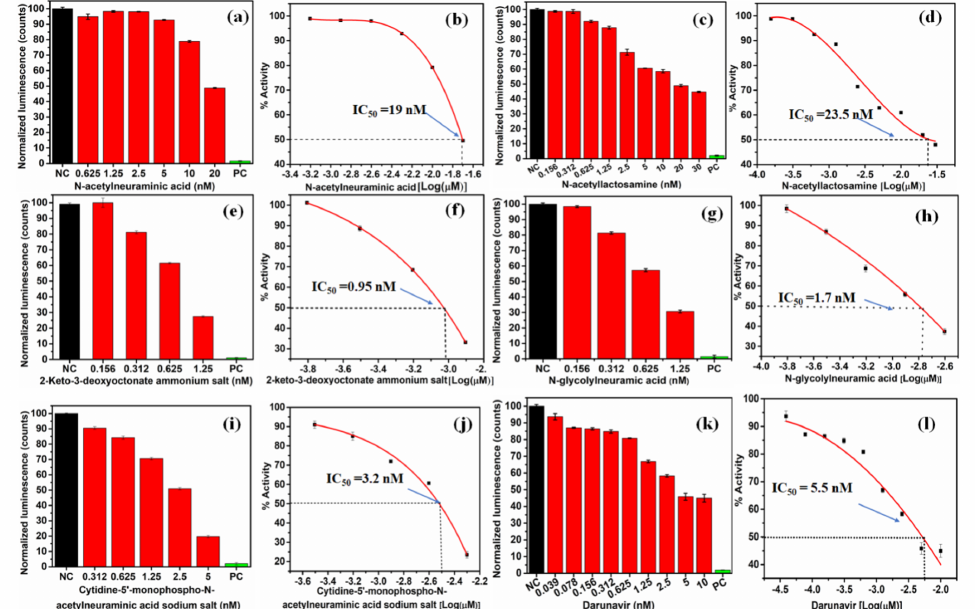
Figure A2. The ACE-2: SARS-CoV-2 Spike Inhibitor Screening assay was performed as de- scribed in the Materials and Methods section. The silicic acid family of n-acetyl-neuraminic acid, n-acetyllactosamine, 2-keto-3-deoxyoctonate ammonium salt, and cytidine-5-monophospho-N- acetylneuraminic acid were tested at various concentrations ranging from 0.1 to 30 nM to evaluate their ability to inhibit the binding of spike protein to immobilized ACE2 by using the ACE-2:SARS- CoV-2 Spike Inhibitor Screening Assay Kit. Chemiluminescence was measured using a FluoStar Omega Luminescence fluorescent microplate reader as per the ACE2:SARS-CoV-2 Spike Inhibitor Screening assay manufacture’s instructions. Normalized luminescence intensity ( a , c , e , g , i , k ) and ACE-2 and SARS-CoV-2 protein percentage inhibition activity ( b , d , f , h , j , l ) of (N-acetyl-neuraminic acid, N-glycolylneuraminic acid, 2-Keto-3-deoxyoctonate ammonium salt, n-glycolylneuramic acid, cytidine-5-monophospho-N-acetylneuraminic acid sodium salt, and darunavir. The experiment was performed twice for all